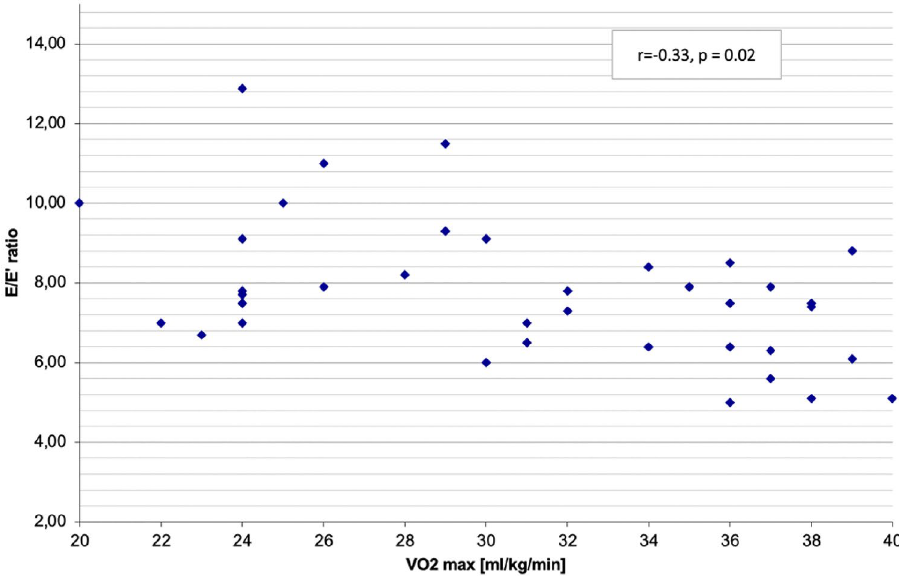
Figure 2. Correlation between the maximal oxygen consumption (VO2max) and E/E’ ratio. E/E’—the ratio of the E wave of mitral inflow measured in the pulse wave doppler to the E’ velocity in the medial site of the mitral annulus measured in the tissue doppler imaging, VO 2max —maximal oxygen